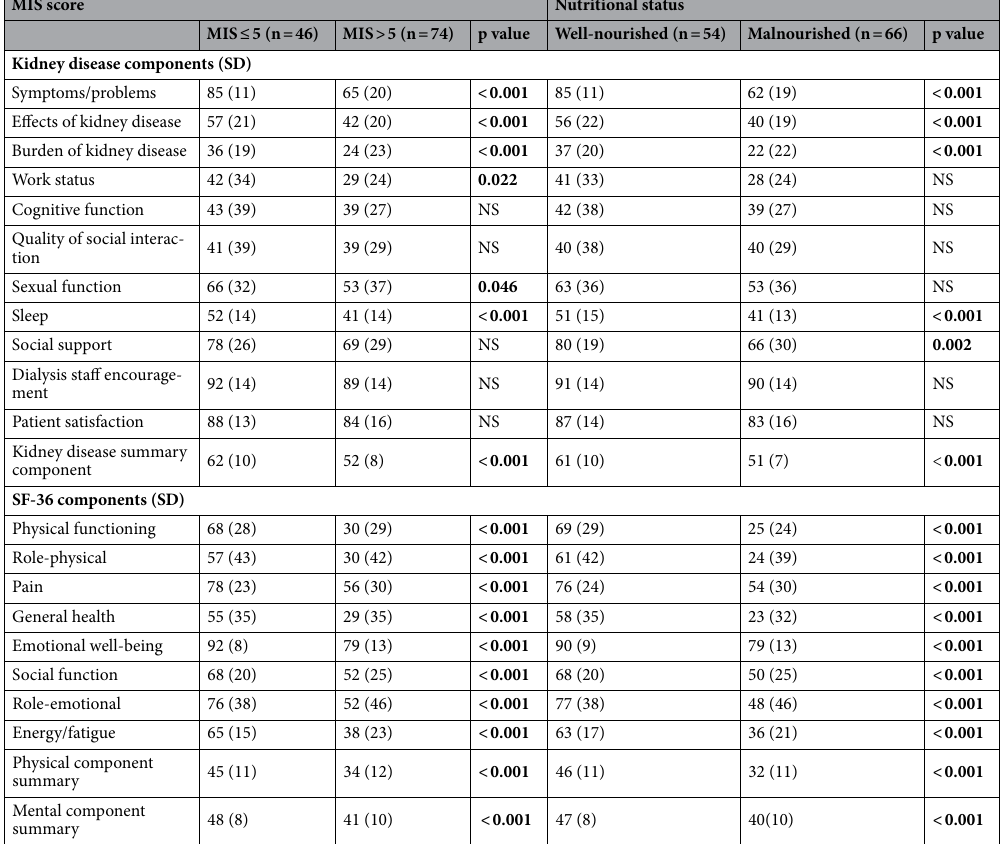
Table 2. Scores on the general summary areas according to MIS scale scores and nutritional status. Significant values are in bold. Data are expressed as mean ± standard deviation for normal data. N/S Not significant.